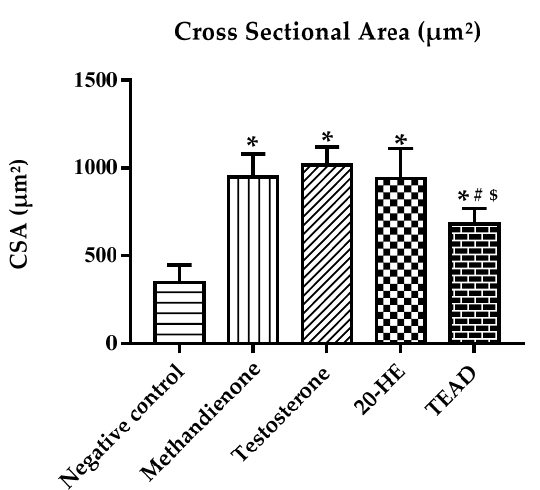
Figure 14. Cross sectional area of treated rats. * : Significantly different from the negative control group at p < 0.0001. $ : Significantly different from the testosterone group at p < 0.0001. # : Significantly different from the methandienone group at p = 0.0004.